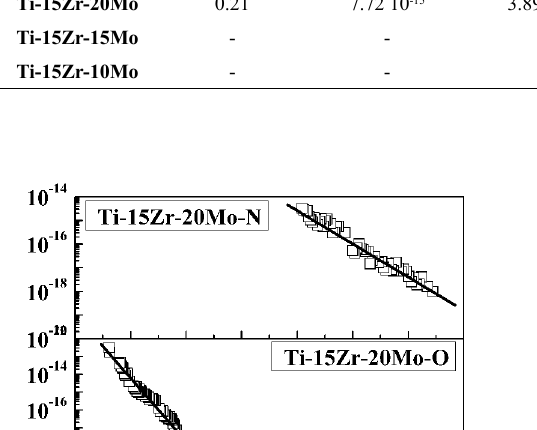
Table 3. Diffusion parameters for Ti-15Zr-Mo alloys system.